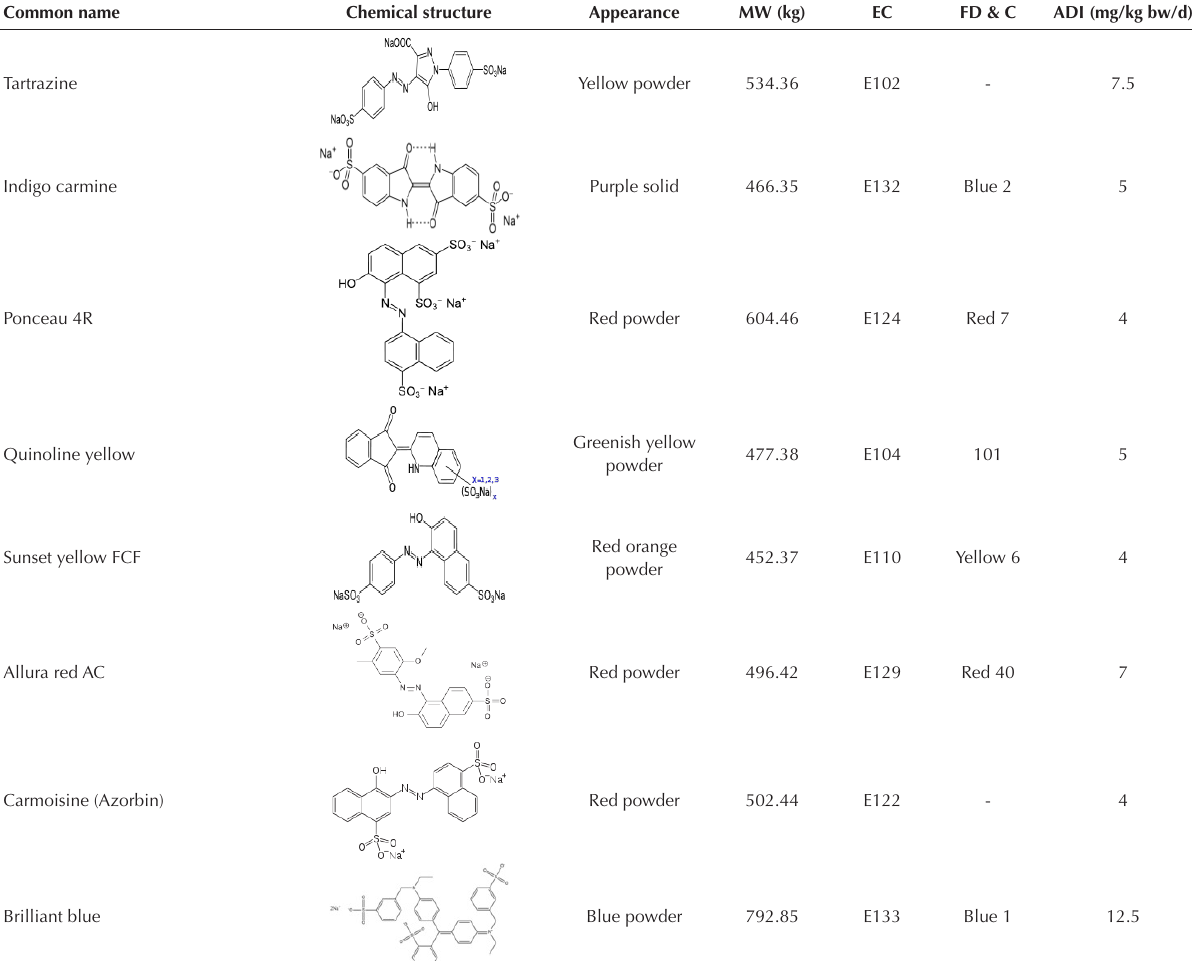
Table 1. Common Name, Chemical Structure, Appearance, Molecular Weight (MW), European